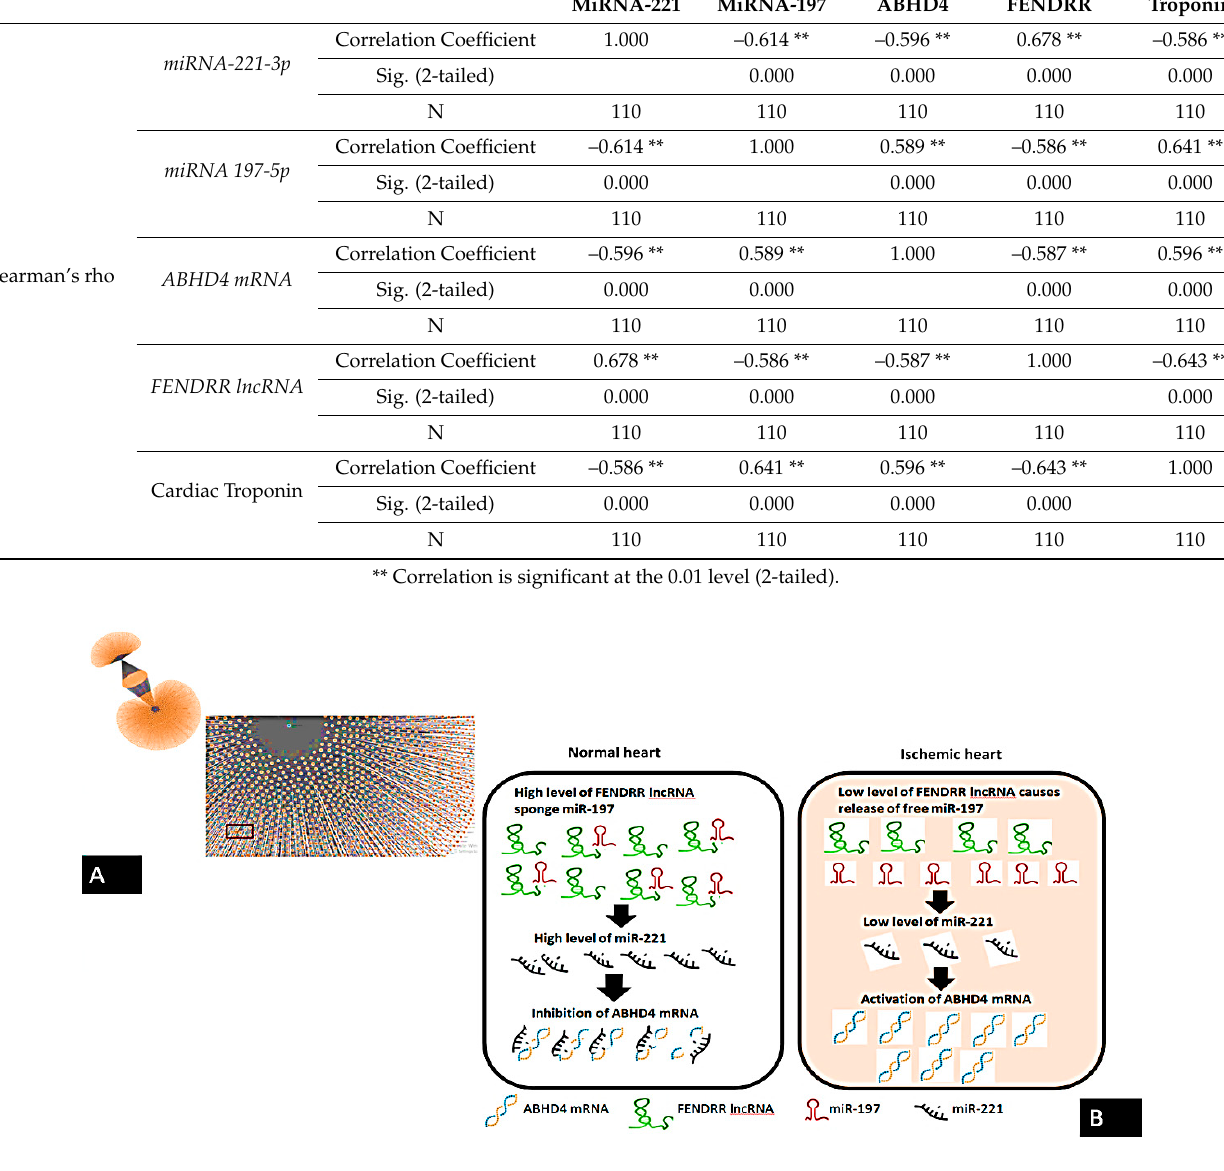
Figure 5. Summary of the molecular signaling of ABHD4-regulating RNA panel in ACS based on putative interactions: ( A ) ABHD4 interacting with both hsa-miRNA-221 and hsa-miRNA-197 as retrieved from miRWalk database, ( B ) Mechanistic signaling of ABHD4 -regulating RNA panel in ACS. Based on the interaction between ABHD4 and retrieved RNAs network, we hypothesized that down-regulation of FENDRR lncRNA in ischemic heart results in the release of free miR-197 with subsequent downregulation of miR-221 accompanied with the activation of